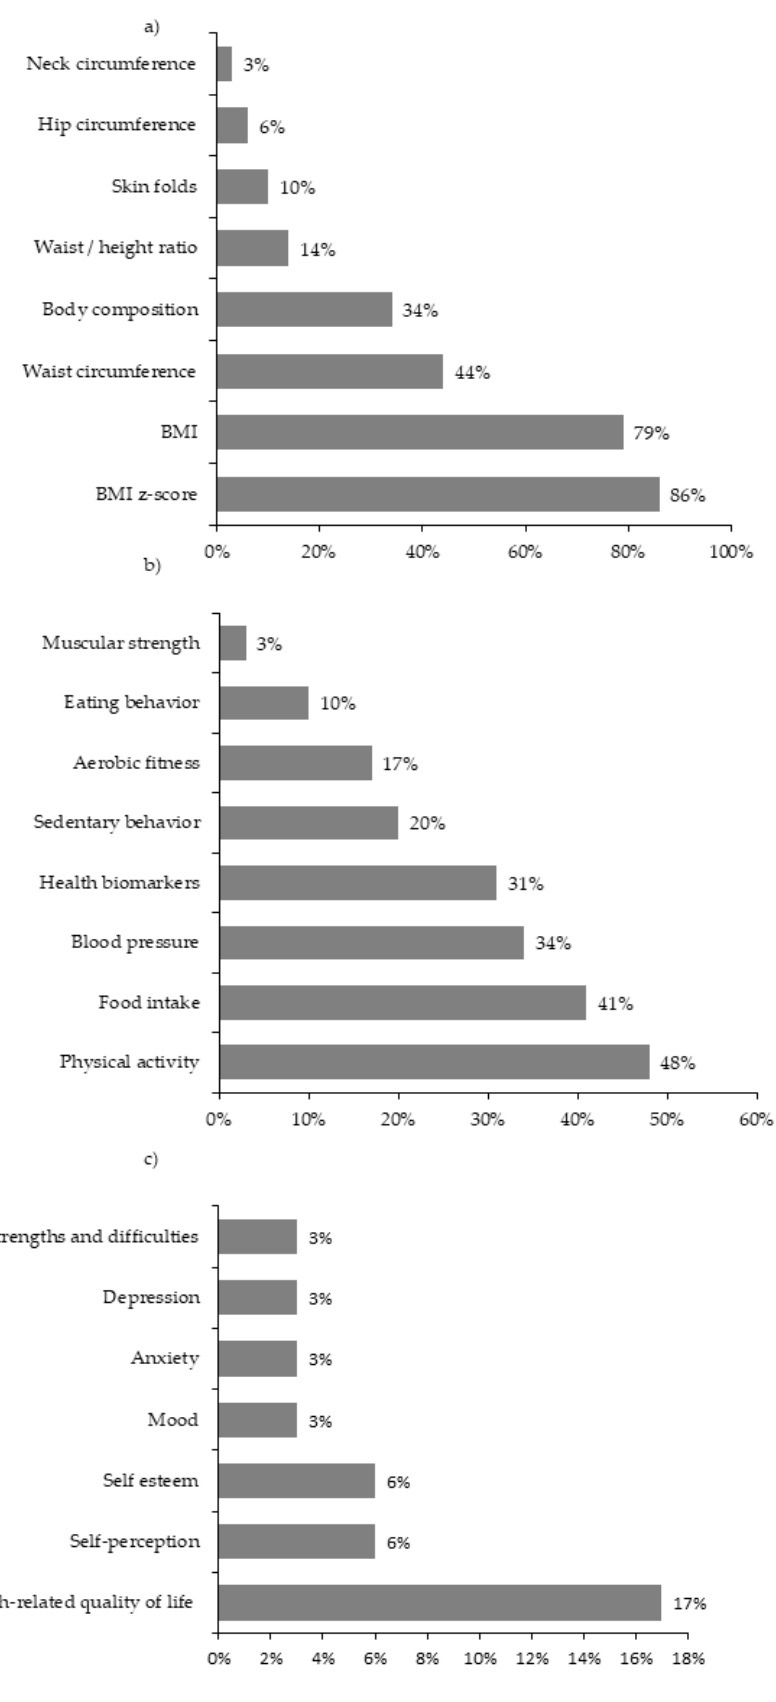
Figure 3. Variables of ( a ) nutritional status, ( b ) physical and health condition, and ( c ) psychological